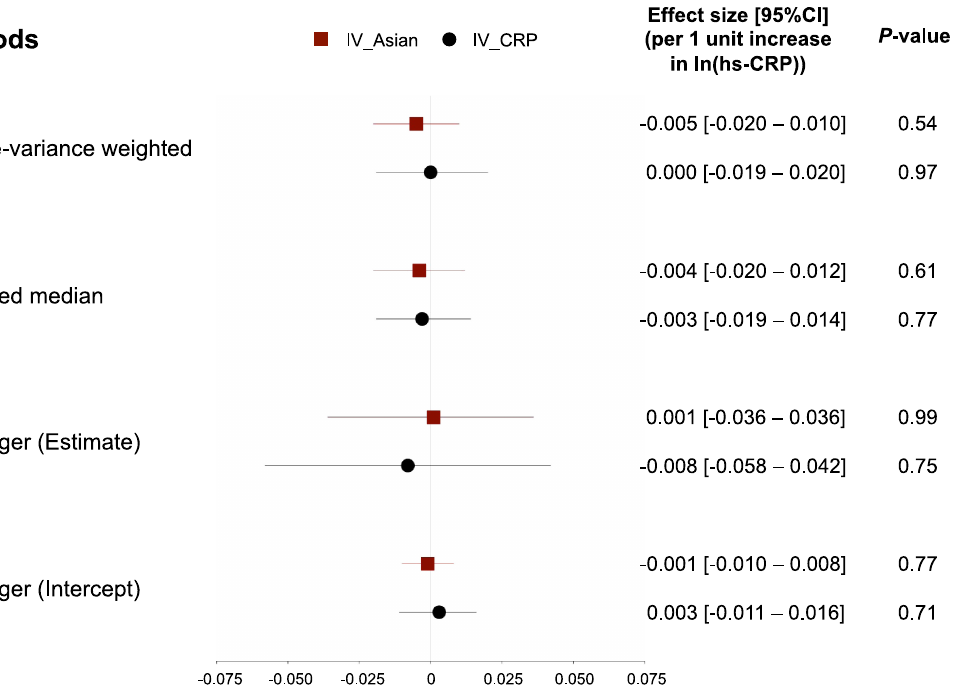
Figure 1. The results of two-sample MR study using two di ff erent IVs (IV CRP and IV Asian ). E ff ect sizes on the causal relationship between hs-CRP (X) and eGFR (Y) were estimated in three di ff erent MR methods. Estimates on eGFR are shown per 1 unit increase of log(hs-CRP). Red blocks and solid lines indicate the estimates and 95% CI using IV Asian , while black blocks and solid lines indicate the estimates and 95% CI using IV CRP . CI, con fi dence interval; eGFR, estimated glomerular fi ltration rate; hs-CRP, high-sensitivity C-reactive protein; IV, instrumental variable; MR, Mendelian